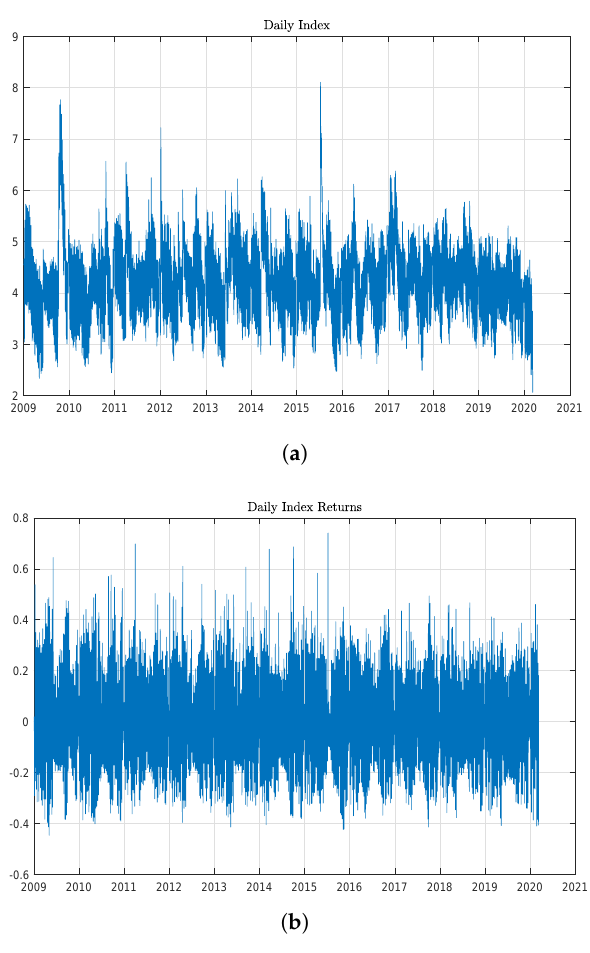
Figure 9. Index value I t , panel ( a ), and Index returns R t , panel ( b ), over the period 1 January 2009–10